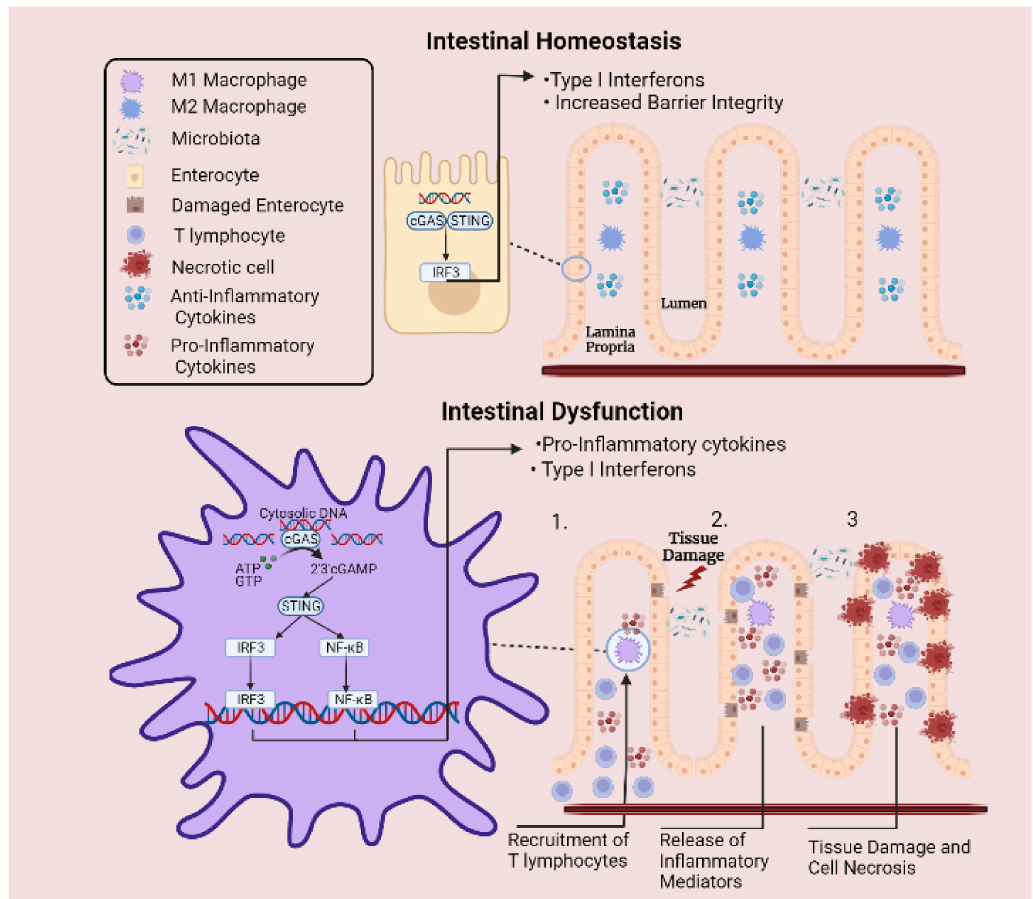
Figure 3. Involvement of cGAS-STING signalling pathway in intestinal inflammation. Under normal circumstances, cytosolic DNA is sensed by cGAS-STING signalling axis, which is involved in promot- ing intestinal barrier integrity. Meanwhile, excessive inflammation is prevented by cytosolic DNAse enzymes that degrade free DNA. However, under inflammatory conditions, the regulatory capacity of these enzymes is overcome when a DNA threshold is reached, leading to abnormal levels of cytosolic DNA. Upregulated expression of STING protein and elevated pathway activation culminates in sustained release of pro-inflammatory cytokines and type I interferons. ( 1 ) This mechanism activates the adaptive arm of the immune system and leads to the recruitment of T lymphocytes to the site of injury. ( 2 ) Perpetual release of inflammatory mediators by T lymphocytes leads to aggregations of immune cells and extensive release of inflammatory mediators. ( 3 ) Surrounding epithelial cells are damaged by the sustained inflammatory response, resulting in cell necrosis and tissue